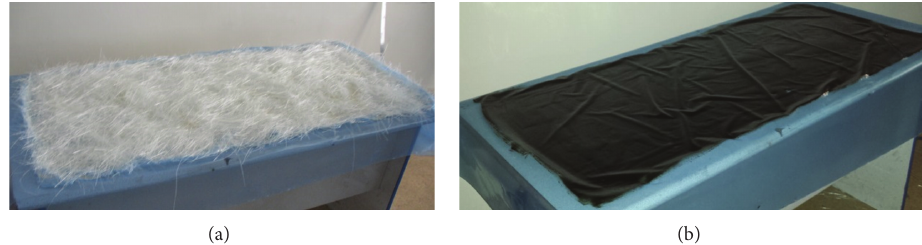
Figure 1: Prepreg formulations containing (a) CaCO 3 and (b) basalt particles.